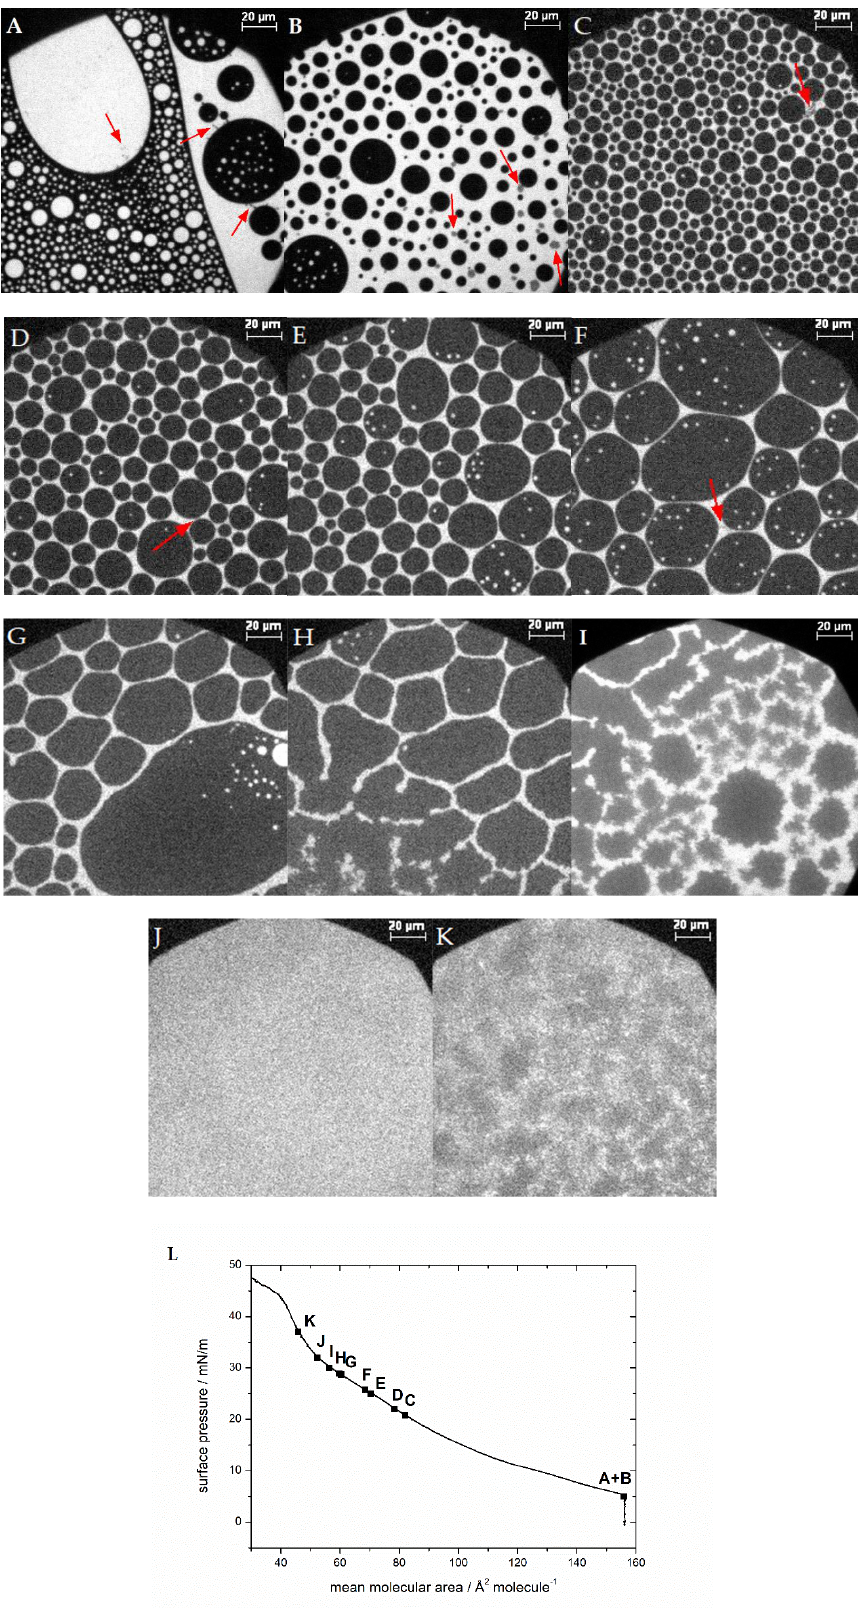
Figure 5. Representative fluorescence microscopy images of the compression behavior of the lipid monolayer with 44% cholesterol and 0.05 mol% Rh-DHPE on a HEPES–NaCl buffer subphase after the injection of MBP at ca. ( A , B ) [21] 5 mN/m, ( C ) 20.8 mN/m, ( D ) 22 mN/m, ( E ) 25 mN/m, ( F ) 25.8 mN /